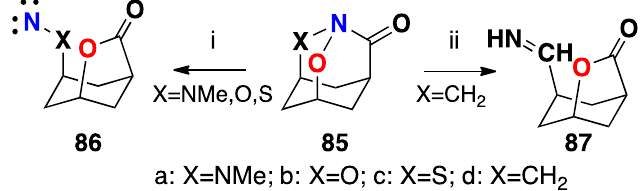
), and rearrangement TA